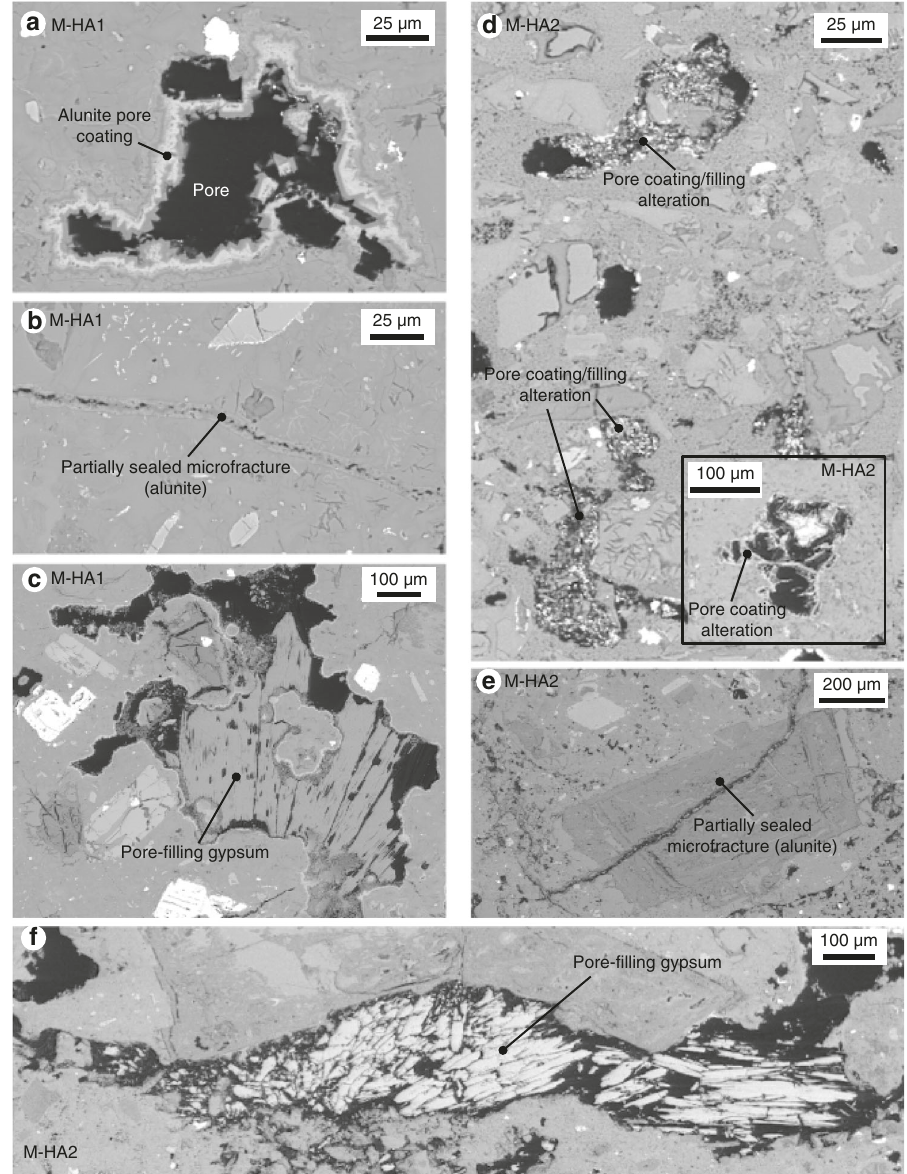
Fig. 2 Porosity- fi lling alteration. Backscattered scanning electron microscope images showing a a pore that is partly fi lled with alunite in block M-HA1, b a fracture partially sealed by alunite precipitation in block M-HA1, c a pore fi lled with gypsum and coated with alunite in block M-HA1, d pore-coating and pore- fi lling alteration in block M-HA2, e a fracture partially sealed by alunite precipitation in block M-HA2, f a pore fi lled with gypsum in block